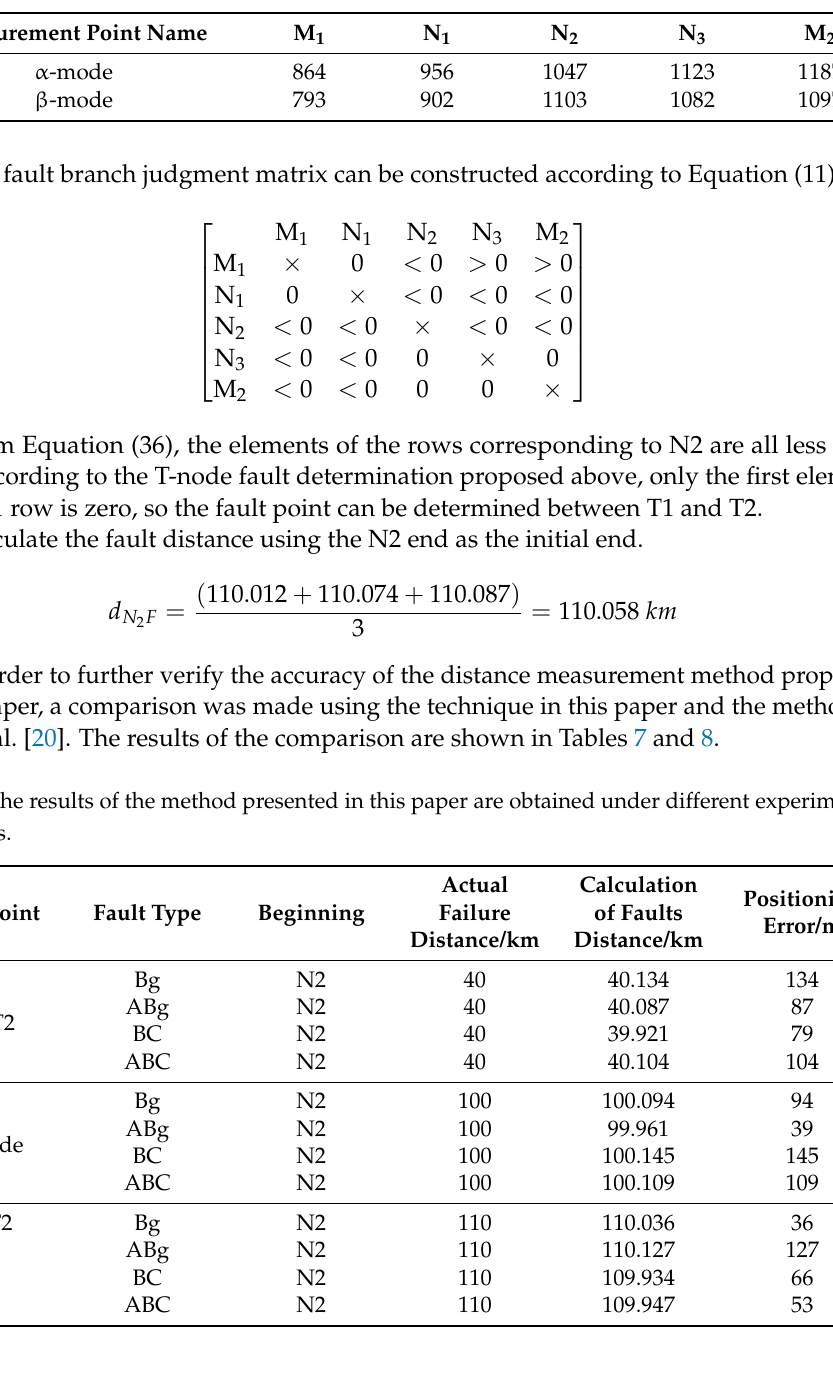
Table 6. Sampling numbers that the initial wave arrives at each measurement when the fault occurs on a T node.